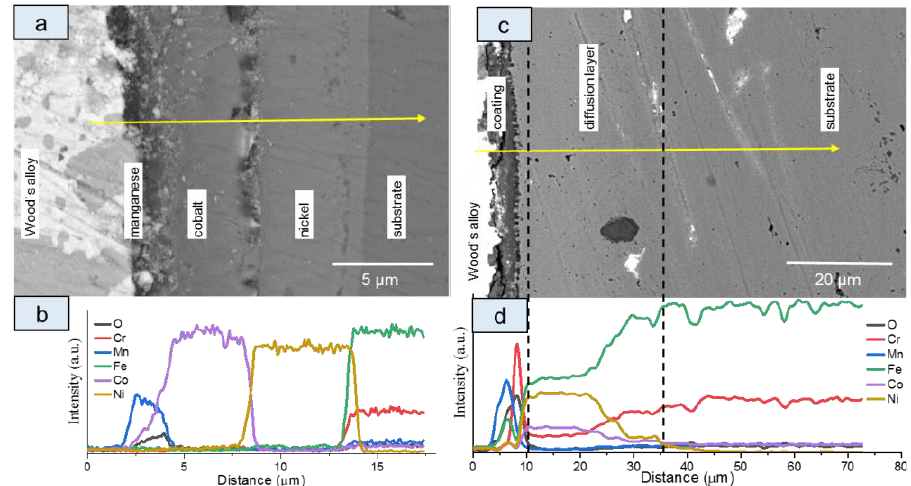
Figure 2. SEM images and element distribution profiles of cross-sections of Fe-Cr steel samples after electrodeposition of nickel, cobalt, and manganese layers ( a , b ) and oxidizing annealing ( c , d ). The yellow arrow indicates the line along which the EDX spectra were collected and their direction.